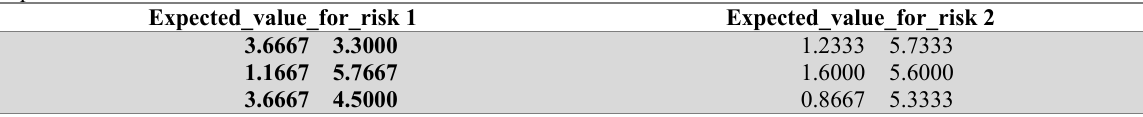
Expected Value of Risks